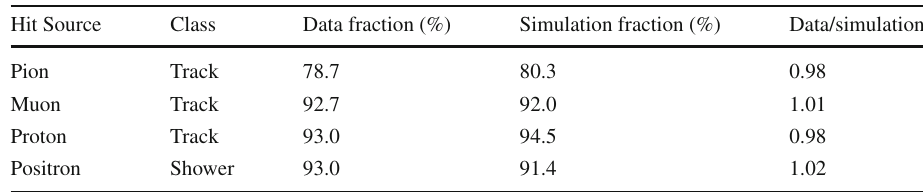
classifier scores for different particle species in the ProtoDUNE-SP beam. The error bars on the experimental data are statistical